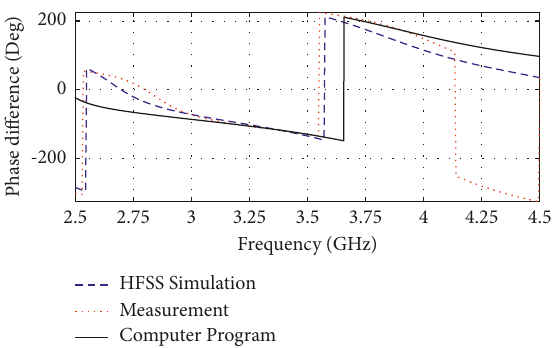
Figure 17: Phase difference between through and coupled ports of 10dB ATRD coupler.